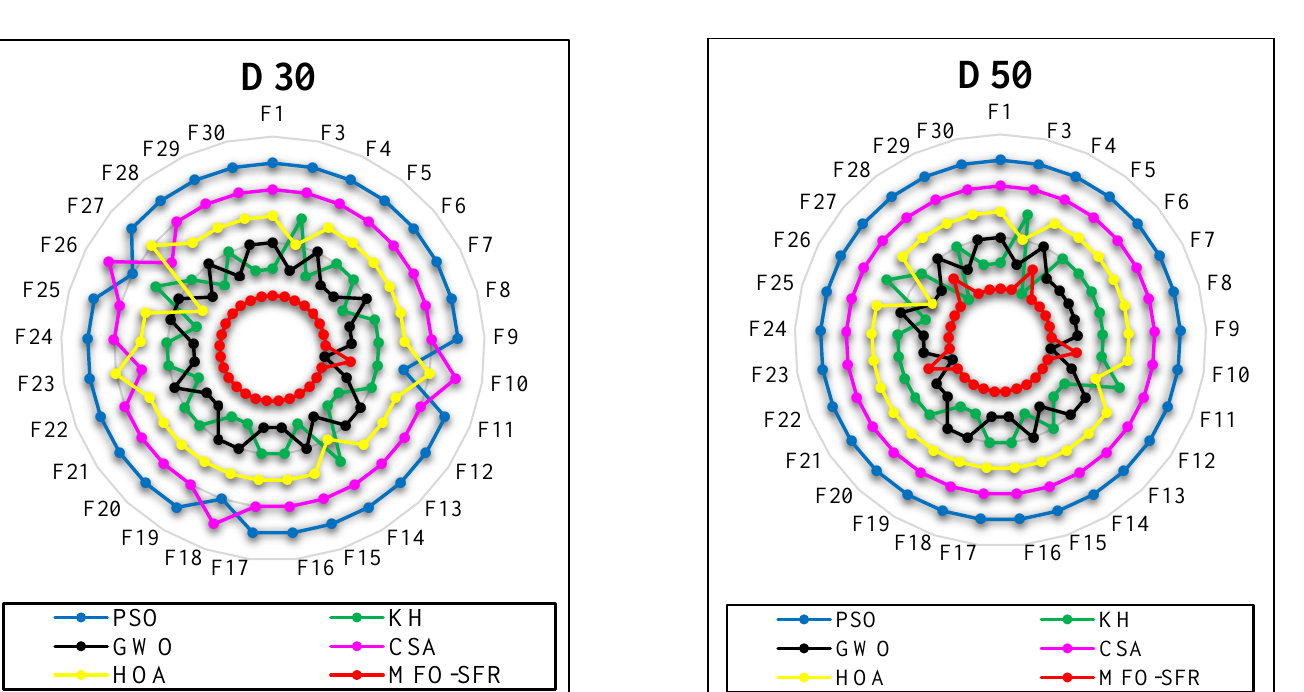
Figure 4. Comparison of the convergence behavior of MFO-SFR and well-known algorithms for CEC 2018 test functions with 30 and 50 dimensions.